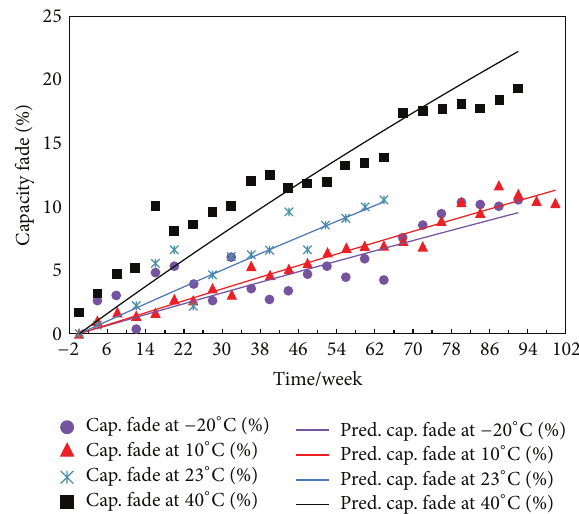
Figure 4: Variation of ln (𝐾) versus 1/𝑇 for five different types of cells, Yardney, SAFT, MP, HE, and 18650 Li ion cells from Sandia.